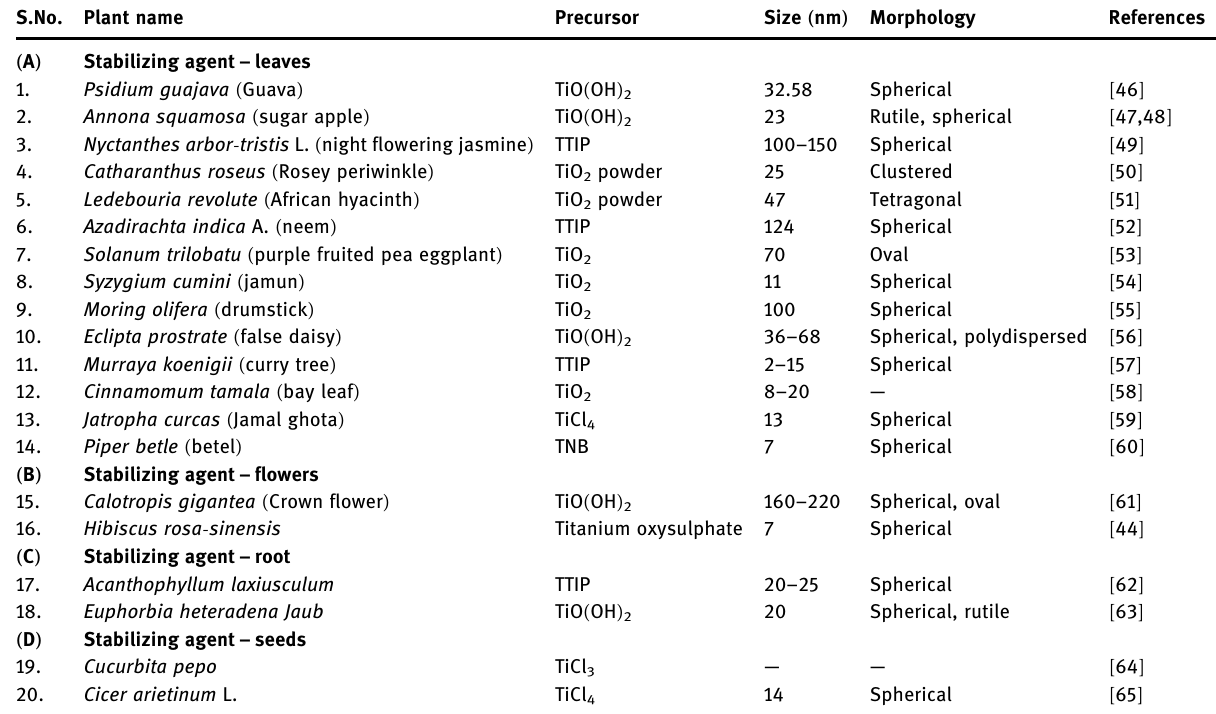
Table 1: Di ff erent plant extracts obtained from various plant parts for the synthesis of TiO 2 -